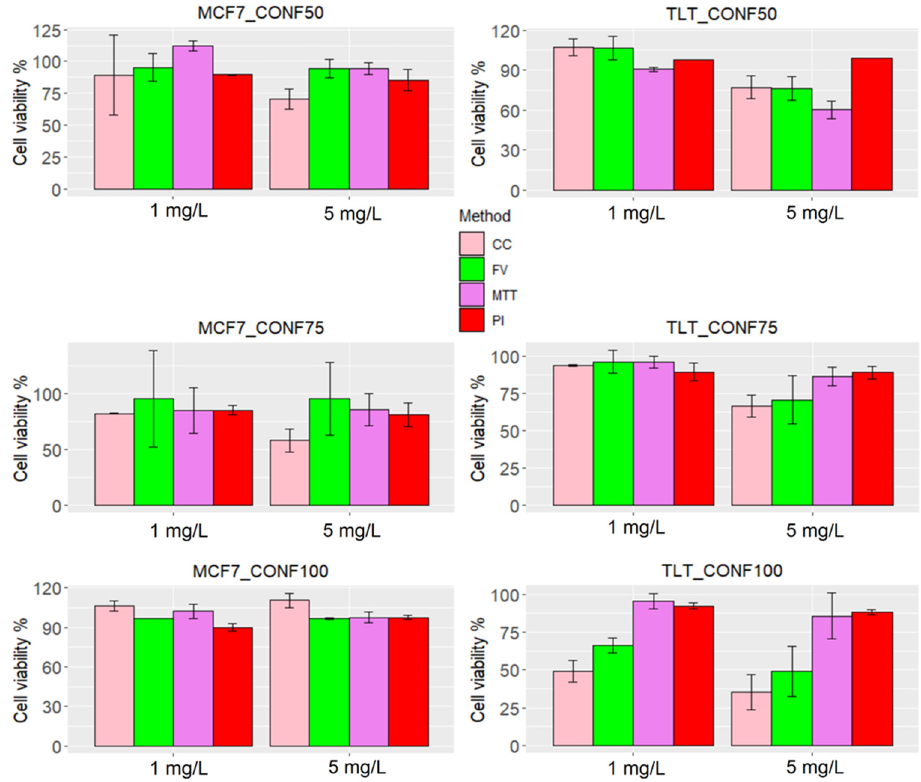
Figure 9. Cell viability of each method in MCF7 and TLT cell lines. The measurement of the treated samples (1 mg/L and 5 mg/L arsenic) was compared with the measurement of the control group and presented as % viability. The viability of each group is shown with different colors: cell number is shown with a pink bar, MPCVA with a green bar, MTT with a purple bar, and PI with a red bar.